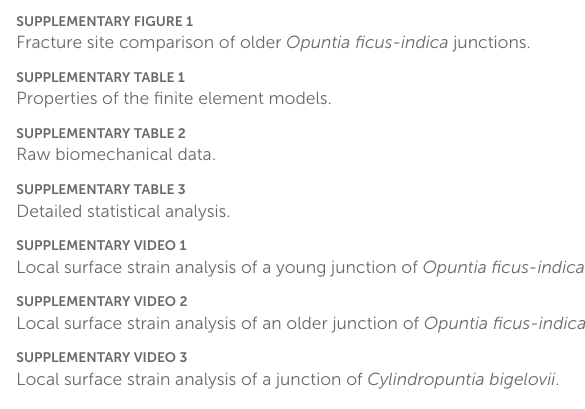
SUPPLEMENTARYFIGURE1 Fracture site comparison of older Opuntia ficus-indica junctions. SUPPLEMENTARYTABLE1 Properties of the finite element models. SUPPLEMENTARYTABLE2 Raw biomechanical data. SUPPLEMENTARYTABLE3 Detailed statistical